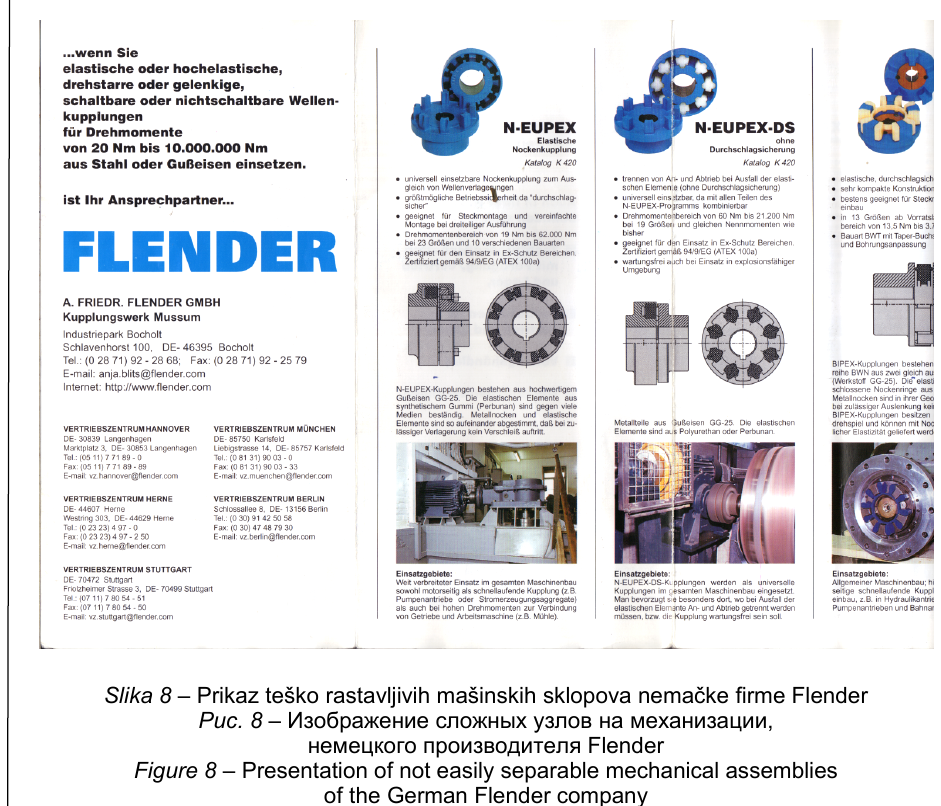
Рис . 8 – Изображение сложных узлов на механизации , немецкого производителя Flender Figure 8 – Presentation of not easily separable mechanical assemblies of the German Flender